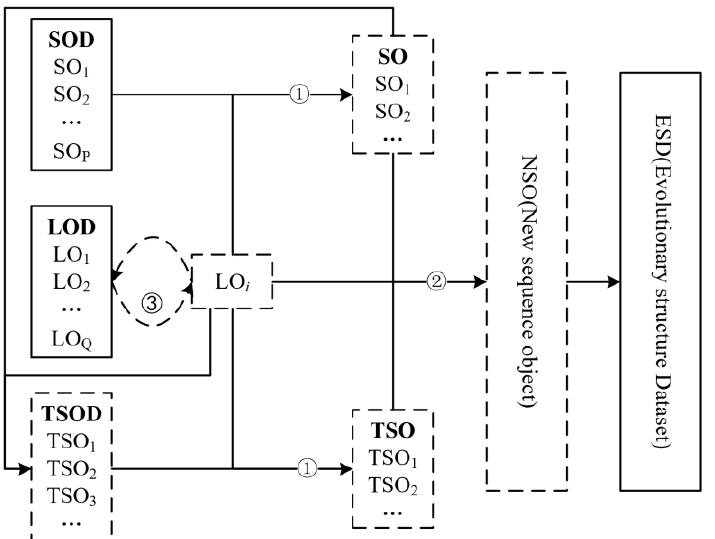
Figure 5. Workflow of the sequence-linked object-based algorithm. SO, sequence object; TSO, temporary sequence object; LO, linked object; SOD, sequence object dataset; LOD, linked object dataset; TSOD, temporary sequence object dataset.